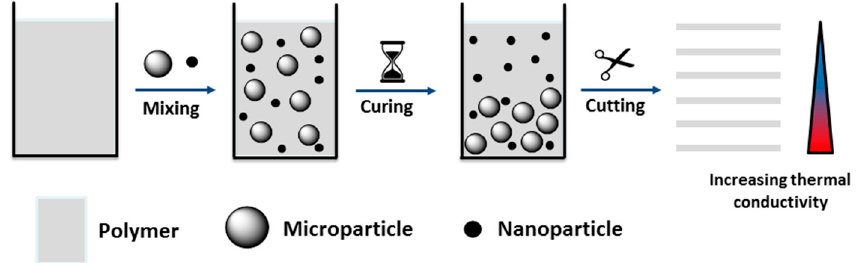
Figure 5. Schematic overview of the concept and the preparation of gradient composites containing a mixture of nano- and submicron-scaled particles.